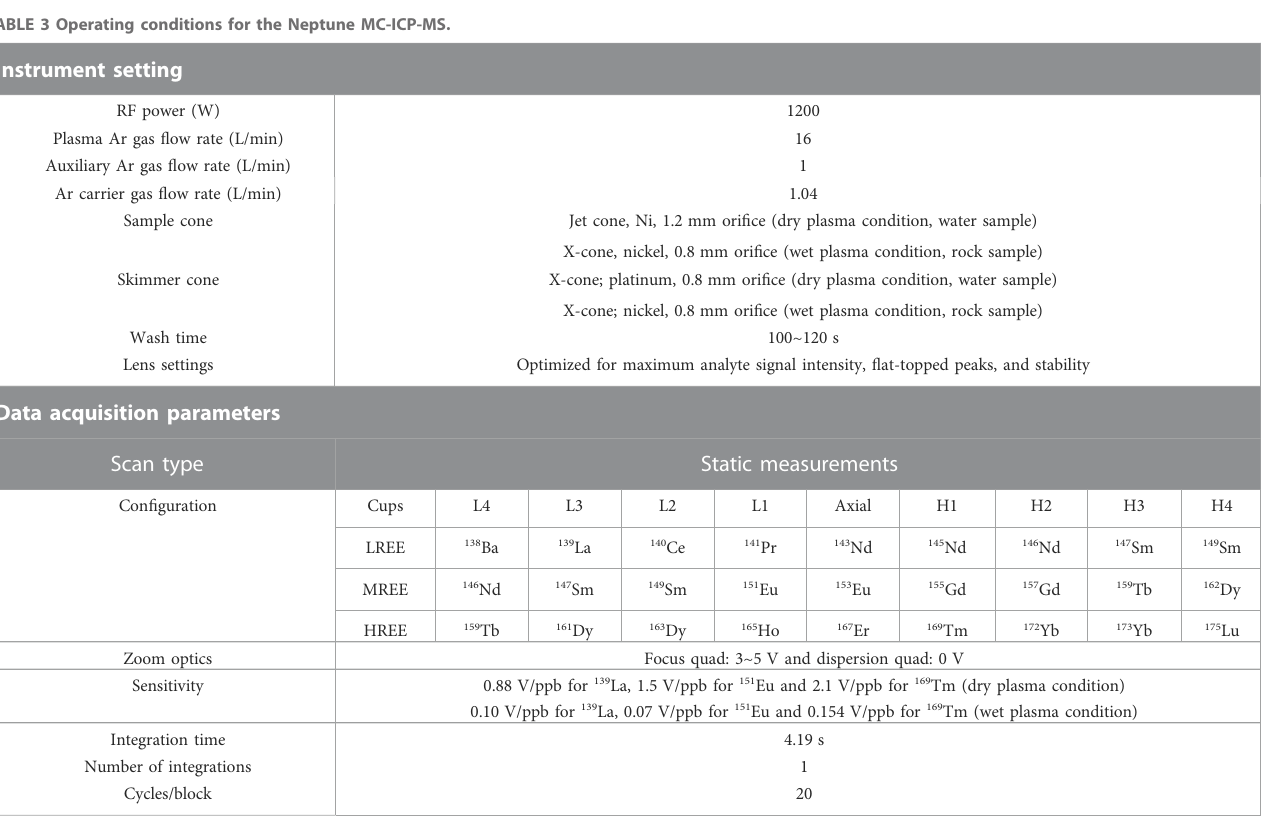
TABLE 3 Operating conditions for the Neptune